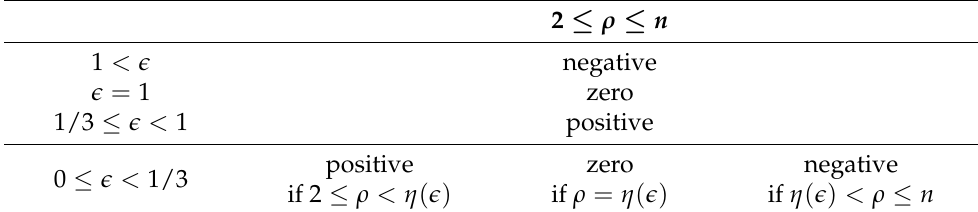
Table 2. The sign of m ( (cid:101) , ρ ) .